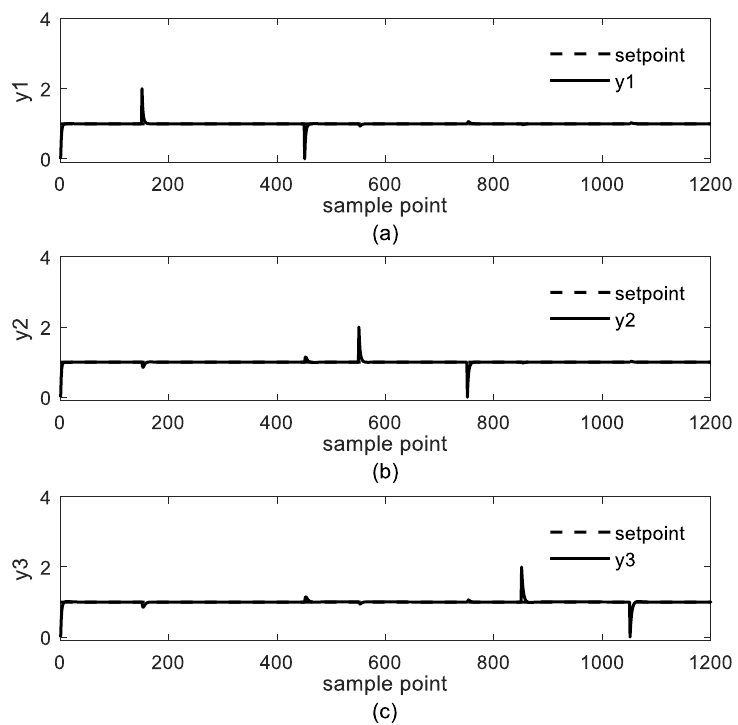
Figure 13. The simulation result of MSDP without noise: ( a ) y 1 —production; ( b ) y 2 —slurry polymer; ( c ) y 3 —catalyst efficiency.